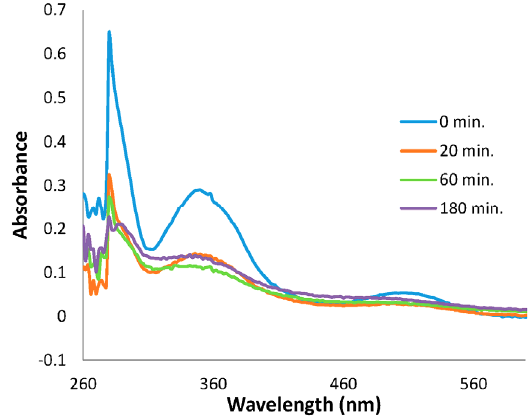
Figure 6. UV-Visible electronic absorption spectra taken from the solution during the catalytic dehydrogenation of dimethylamine borane starting with Ru(acac) 3